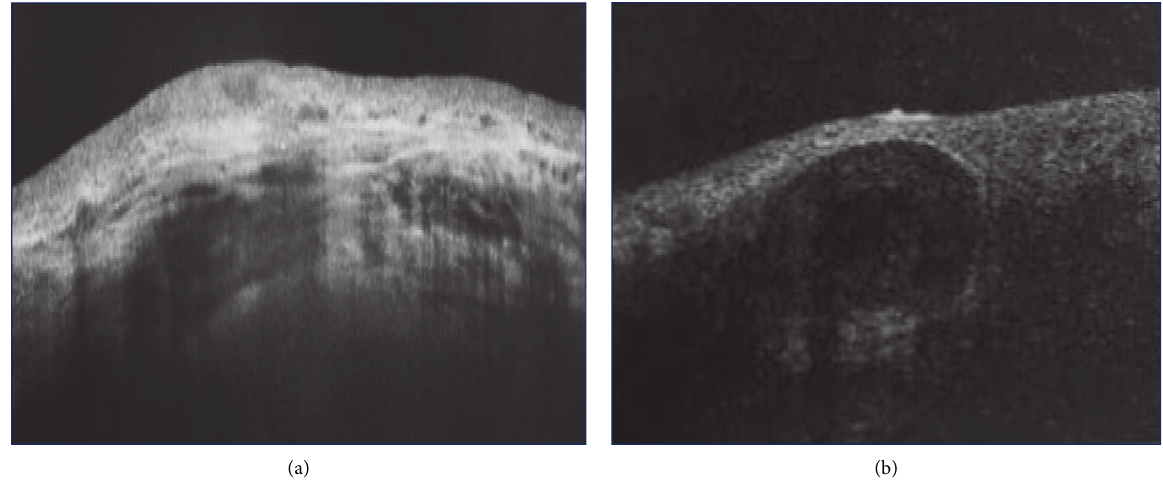
Figure 5: (a) AS-OCT bleb imaging of a female patient in group II at 1 month (hypertensive phase); IOP was 29mmHg. AS-OCTrevealed the presence of encapsulated bleb with dense hyperreflective bleb wall with monocystic fluid-filled bleb cavity; maximal bleb wall thickness was 375 μ m, and bleb wall reflectivity was 132. (b) AS-OCT bleb imaging of a male patient in group II at 3 months (hypertensive phase); IOP was 27 mmHg. AS-OCT revealed the presence of a few number of intraconjunctival cysts and minimal conjunctival hydration with dense hyperreflective areas within the bleb cavity (mostly due to fibrosis); the maximal bleb wall thickness was 389 μ m, and bleb wall reflectivity was